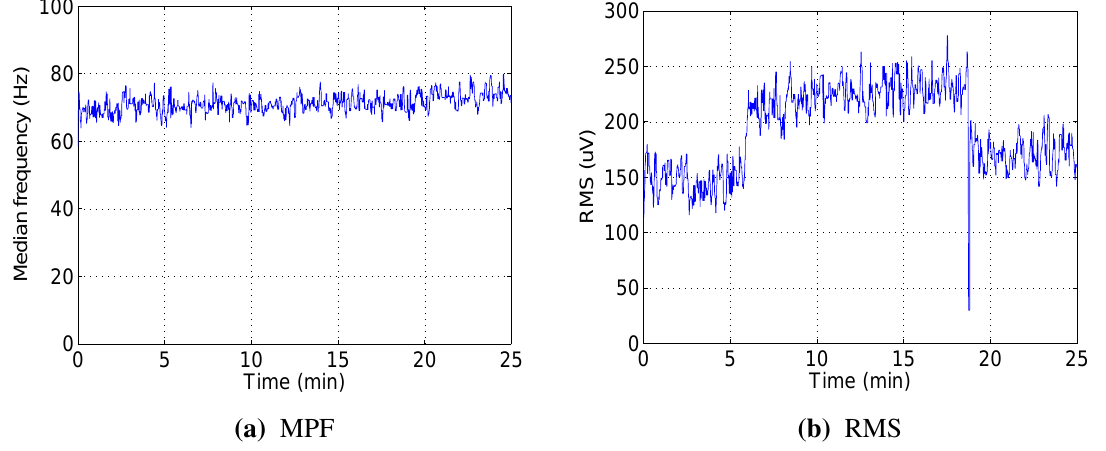
Figure 5. Time courses of the median power frequency and the normalized RMS for right vastus lateralis of Subject